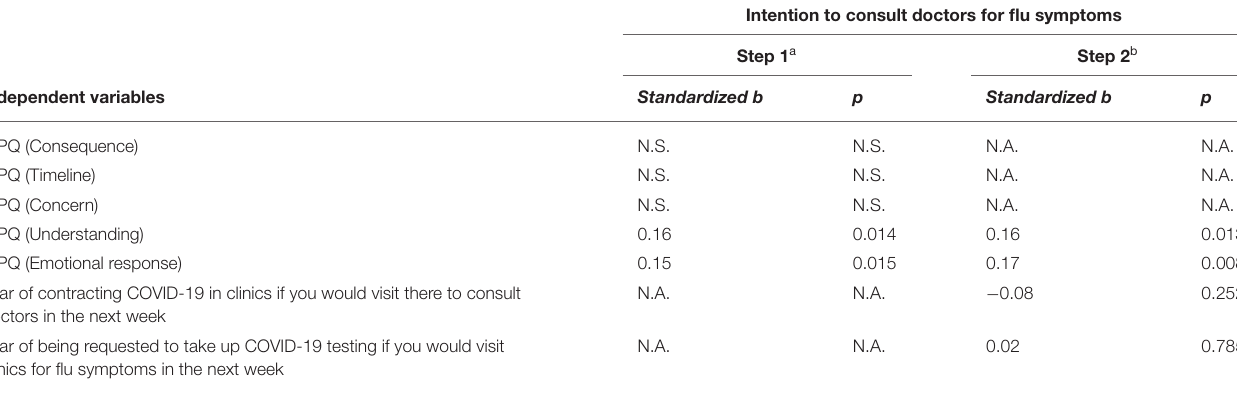
TABLE 5 | Hierarchical regression on the behavioral intention to consult doctors for flu symptoms ( N =